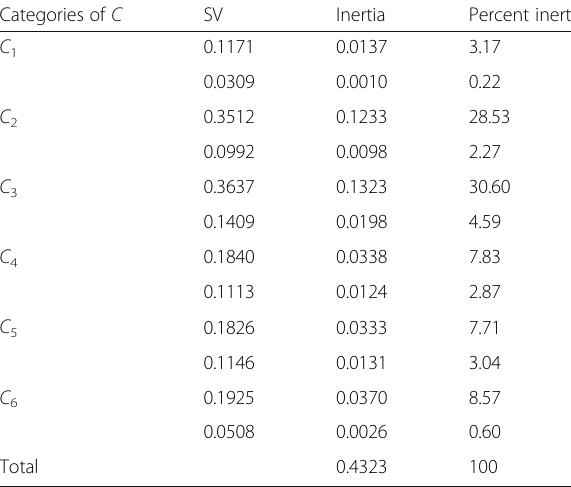
Table 4 Results of Subset MCA based on separate SVDS for Table 2 along B and A across the categories of C Categories of